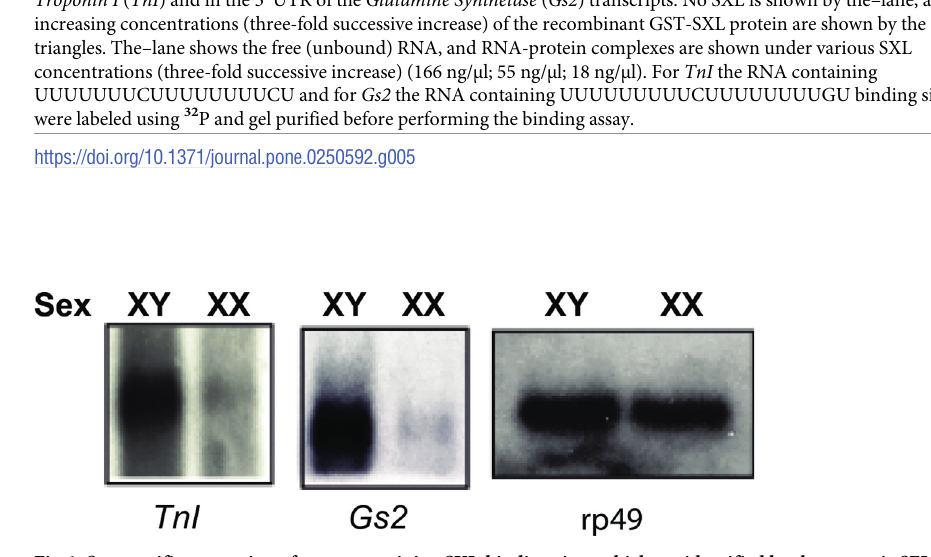
PLOS ONE | https://doi.org/10.1371/journal.pone.0250592 May 24,